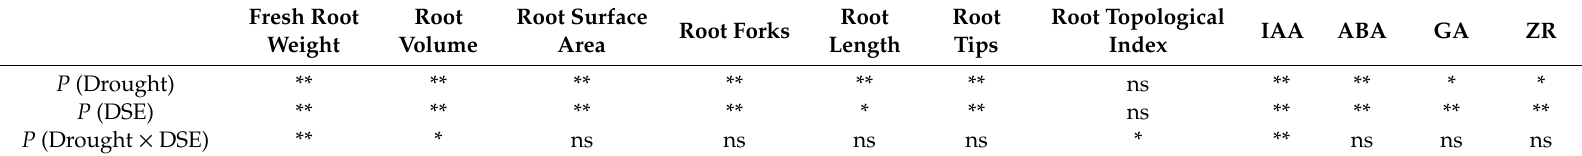
Table 1. Results of two-way ANOVA on the e ff ects of water, DSE, and their interactions on the contents of fresh root weight, root volume, root surface area, root forks, root tips, root length, root topological index, abscisic acid (ABA), indole-3-acetic acid (IAA), gibberellic acid (GA), and zeatin riboside